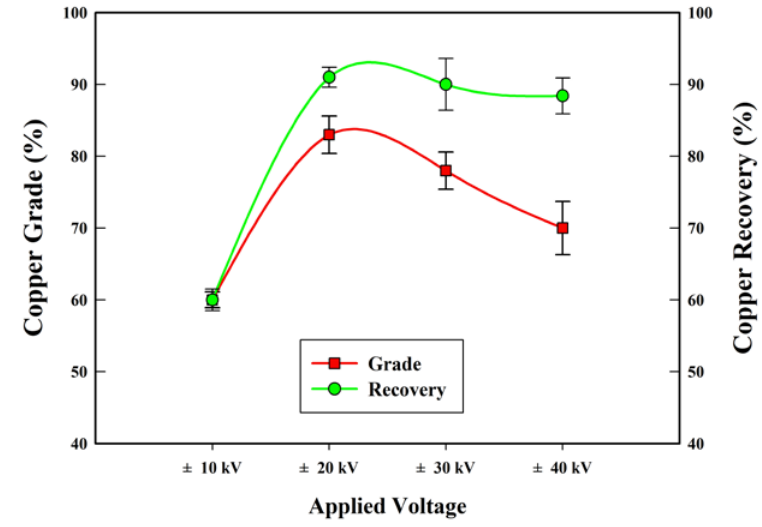
Figure 7. Effects of the applied voltage on the grade and recovery of copper after sieving/washing